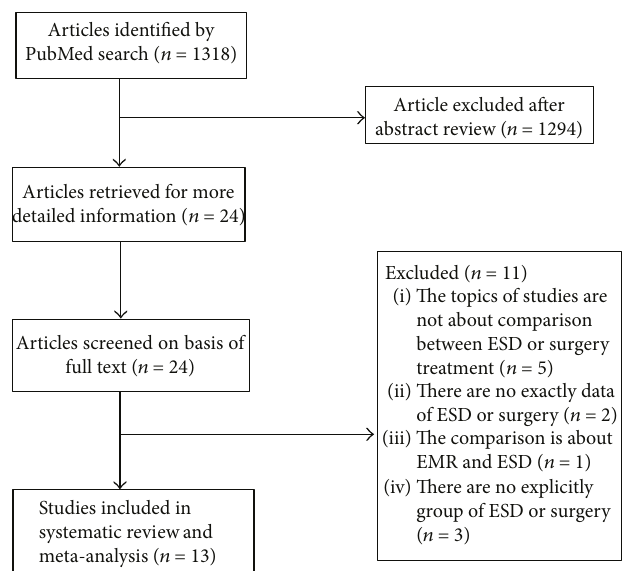
Figure 1: Flow chart used in study. ESD: endoscopic submucosal